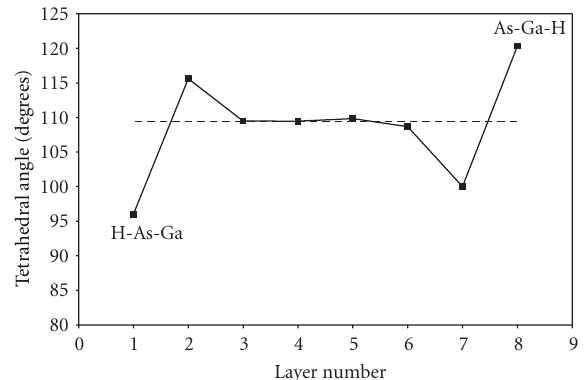
Figure 3: The variation of tetrahedral angle between atoms starting from the arsenide terminated surface (H-As-Ga angle) until we reach the gallium terminated layer (As-Ga-H angle) at the opposite side of the nanocrystal (solid line) using cluster-HF geometrical optimization. This angle is compared with the ideal diamond and zincblende structure tetrahedral angle of 109.47 ◦ (broken line).